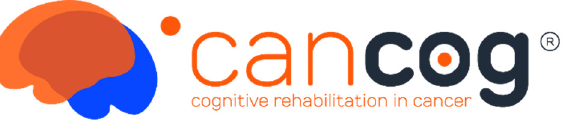
Figure 3. Name and logo of the Portuguese version of the UCLA program: CanCOG ® —Cognitive Rehabilitation in Cancer.